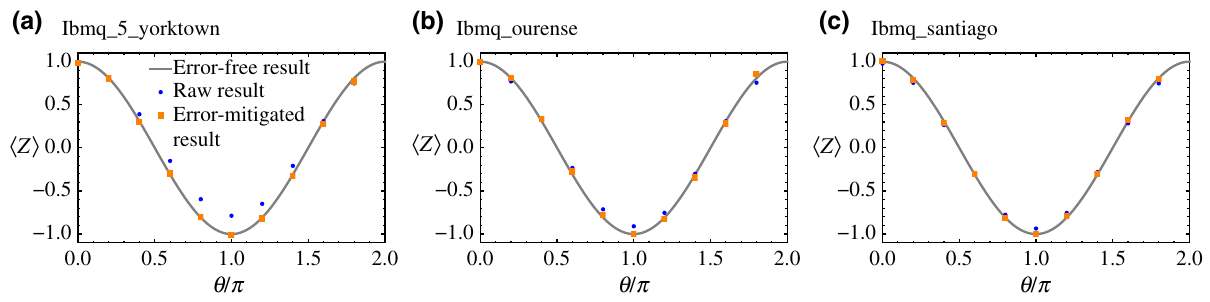
FIG. 10. Computation results of the two-qubit DQCp circuit, obtained from three different quantum hardware. Here (cid:10) Z (cid:2) = com ( e − i θ Z / 2 , I ) is the raw result without error mitigation and (cid:10) Z (cid:2) = com EM ( e − i θ Z / 2 , I ) is the error-mitigated result.